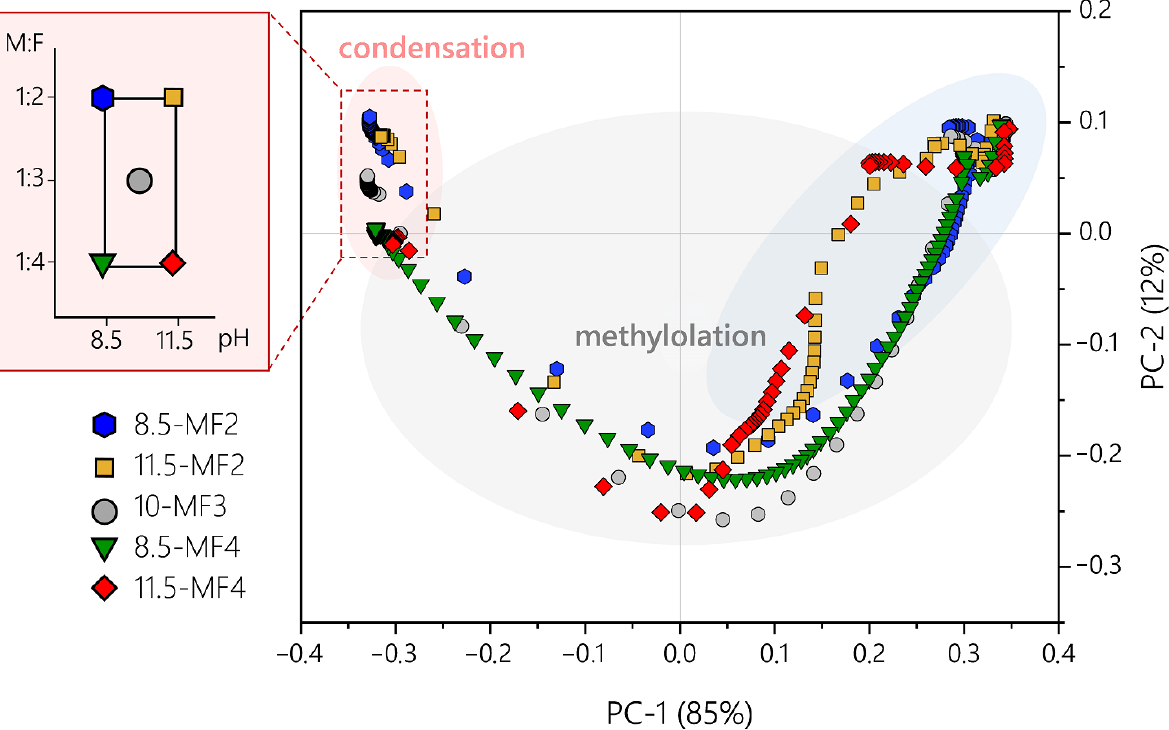
Figure 5. Process trajectories for PCA. Score plot (PC1 vs. PC2) of the PCA analysis of the entire synthetic procedure for five of the prepared MF resins. The score plot shows the process trajectories of the factorial experiments (triangular, rhombic, hexagon and square symbols) and center point (circle) settings of the MF resin syntheses. The reaction phase is indicated by blue (phase 1: reactor filling), grey (phase 2: dissolution/methylolation heterogeneous reaction system) and red (phase 3: condensation in homogenous reaction medium) shadows.